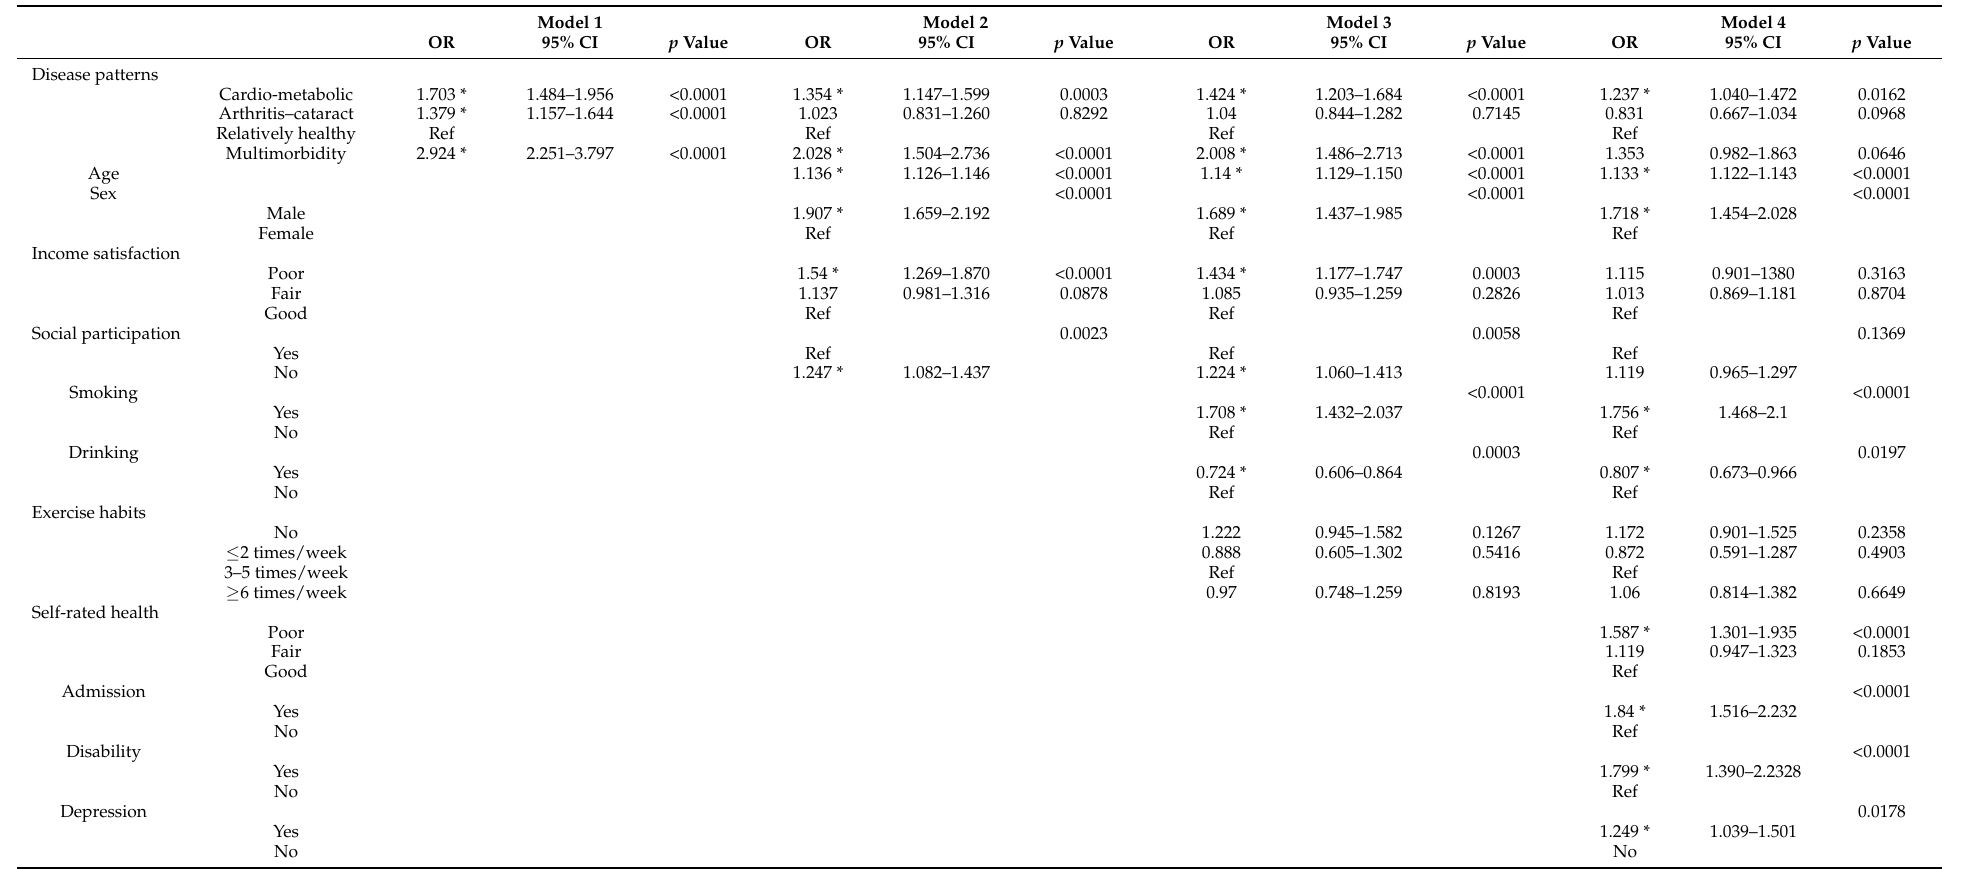
Table 3. Multivariate logistic regression analysis of demographic and clinical characteristics predicting mortality. Model 1: Disease patterns only; Model 2: Adjusted with socioeconomic factors; Model 3: Adjusted with socioeconomic factors and health behaviors; Model 4: Adjusted with socioeconomic factors, health behaviors, and physical